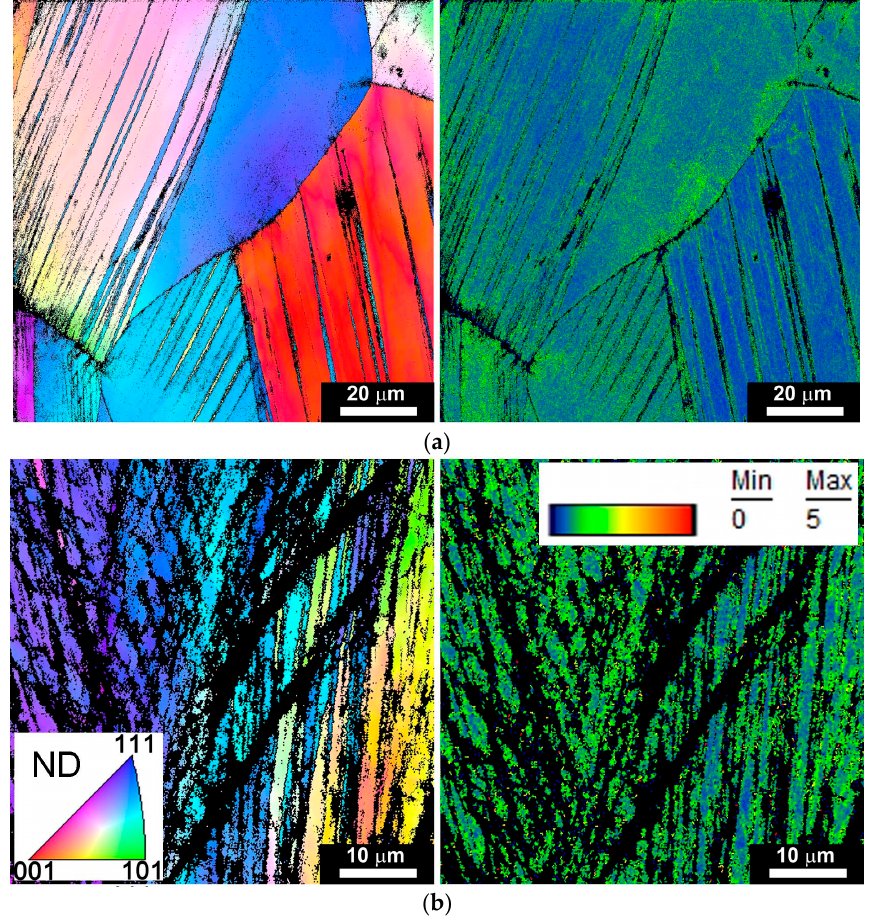
Figure 4. Annealed microstructures of a high-Mn steel subjected to cold rolling reduction of ( a ) 20% or ( b ) 40% and then annealed at 773 K. Left-side images are color orientations corresponding to the normal direction (ND), right-side images are KAM maps. Low-angle and high-angle boundaries are indicated by thin and thick black lines, respectively.